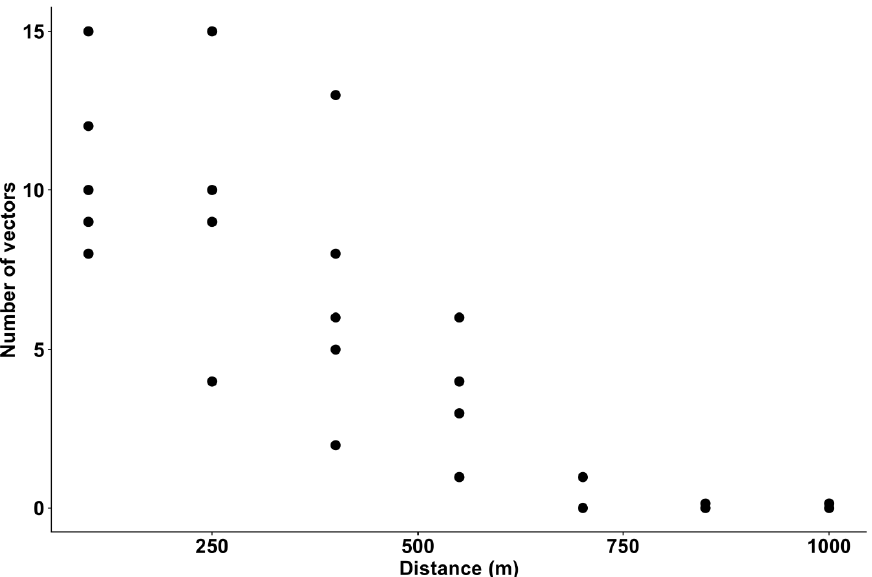
Figure 5. The relationship between the distance to the nearest forest water body and the number of parasite vectors trapped in nest boxes of Pied Flycatchers.